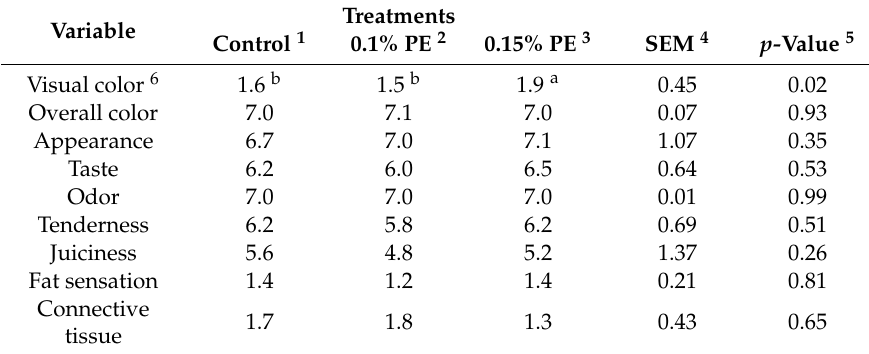
Table 7. Sensory quality of meat from pigs supplemented with plant extracts (PE) during the growing-finishing stage.